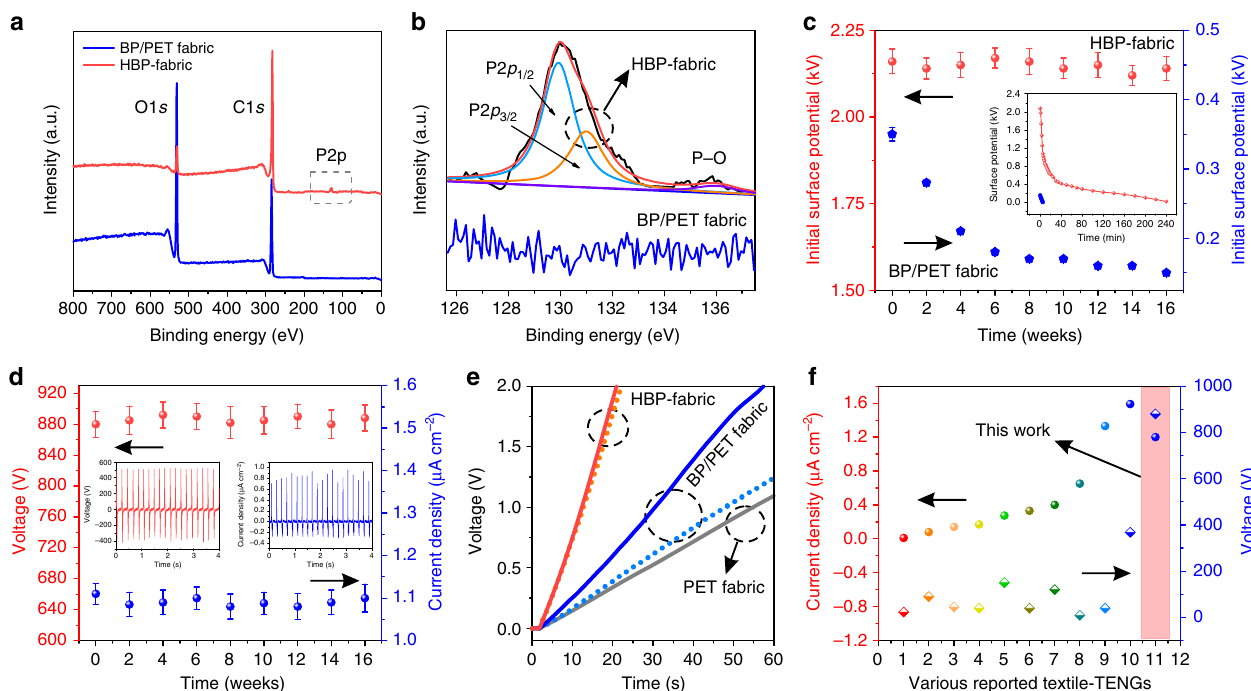
Fig. 5 Durability of textile triboelectric nanogenerator under exposure to ambient conditions. a X-ray photoelectron spectroscopy (XPS) spectra of BP/PET fabric and HBP-fabric that were stored for 11 weeks. The former is the black phosphorus coated polyethylene terephthalate fabric (BP/PET fabric), the latter (HBP-fabric) is PET fabric with successive coating of BP and hydrophobic cellulose oleoyl ester nanoparticles (HCOENPs). b Deconvolution of phosphorus peaks in BP/PET fabric and HBP-fabric, respectively. c The initially saturated surface potentials of BP/PET fabric and HBP-fabric within 16 weeks. Inserts are the sustained time of their surface potential after exposure to air for 16 weeks. d Periodic monitoring of the peak-to-peak output voltages and current densities of textile-TENG within 16 weeks. Insert are the outputs of device placed in ambient environment after16 weeks. e Charging curve of 16 μ F capacitor by devices with fabrics of PET, BP/PET, and HBP-fabric. Solid and dashed curves denote the initial charging curves and charging curves after 16 weeks, respectively. f Comparison with selected important works on textile TENGs. 1 – 10 are various TENGs reported based on silver-coated polytetra fl uoroethylene (PTFE) textile (TENG-1) 28 , Nylon/PET woven textile (TENG-2) 24 , polydimethylsiloxane (PDMS)-coated stainless steel/PET